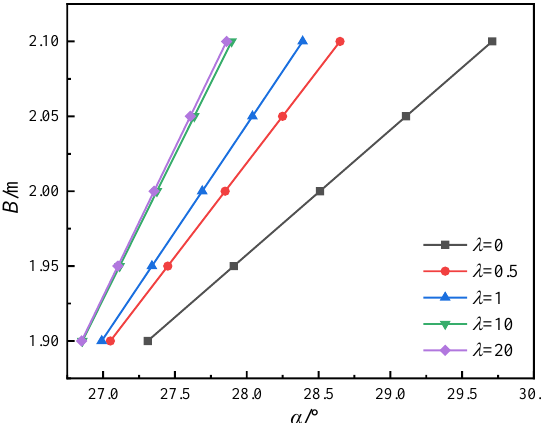
Figure 7. Relationship between support width B and limit angle α.